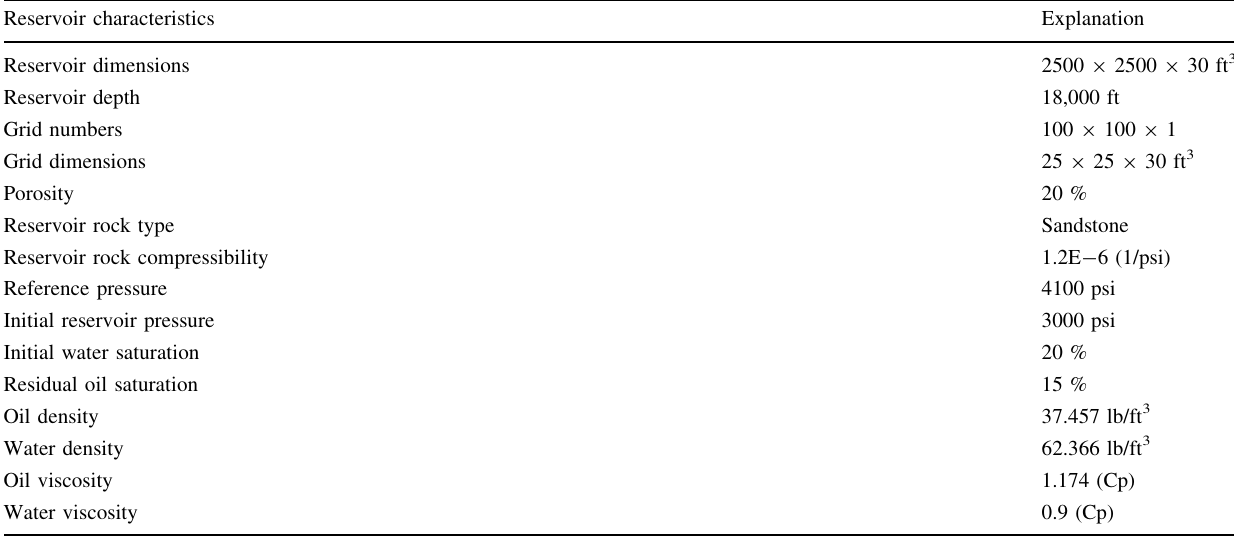
Table 4 The reservoir characteristics